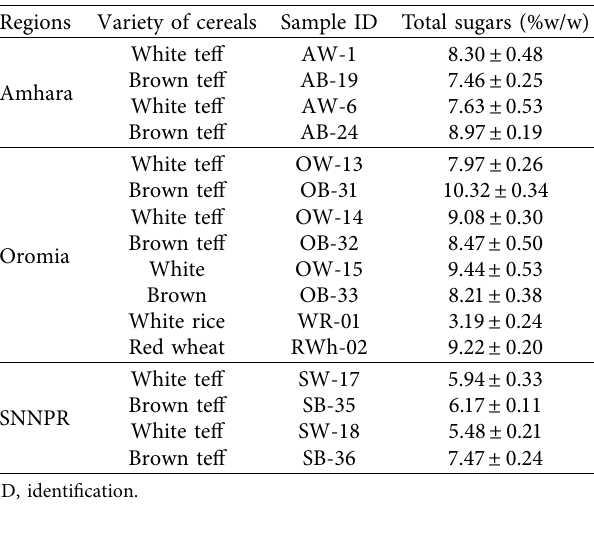
Table 3: Amount of total sugars (mean ± SD) in white and brown tef ( Eragrostis tef (Zuccagni) Trotter), white rice, and red wheat grains determined by the newly developed UV-VIS method.